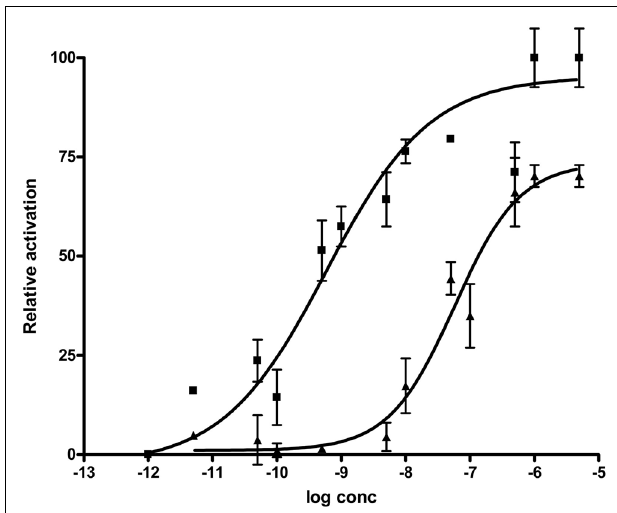
FIGURE 5 | Drosophila SPR is activated by both Rhopr-MIP-7 [W(X 6 )Wamide; squares] and Rhopr-MIP-4 [W(X 7 )Wamide; triangles]. CHO-cells coexpressing aequorin, G α 16 , and Drosophila SPR show a dose-dependent increase of their intracellular Ca 2 + -concentration (detected as aequorin luminescence) when challenged with Rhopr-MIP-4 or Rhopr-MIP-7. Data points represent mean ± SEM of three independent measurements done in triplicate and are given in percentage of the maximal response.The zero response level corresponds to treatment with buffer